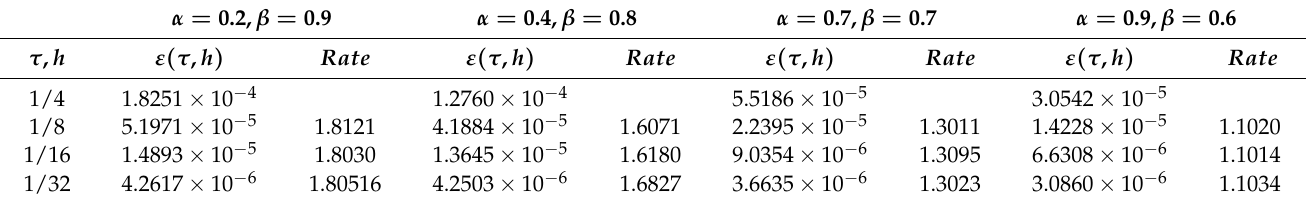
Table 1. The error and convergence rate for Numerical scheme solution of (21) when T = 1, τ = h 2 2 − α . α = 0.2, β = 0.9